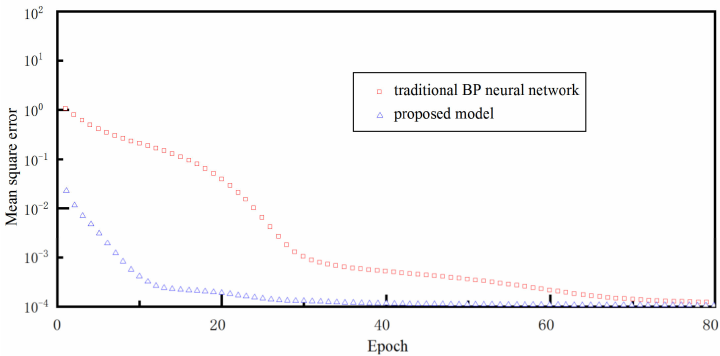
Figure 8. The output error in the iterative optimization